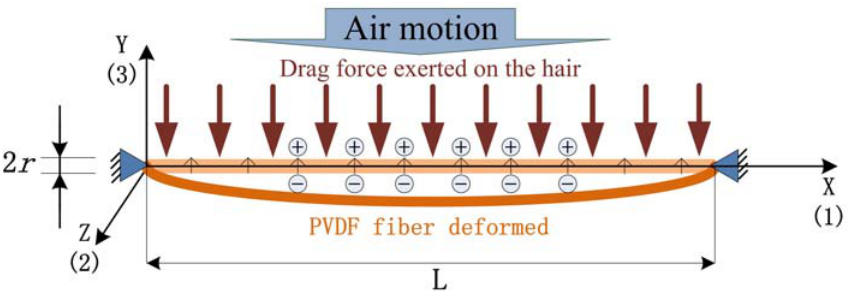
Figure 4. A simplified model of an artificial PVDF hair